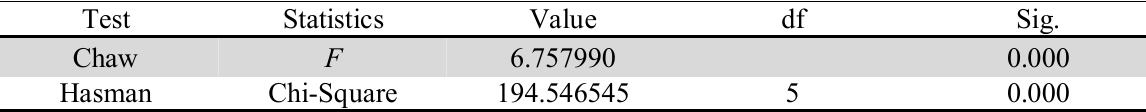
The summary of some statistical test